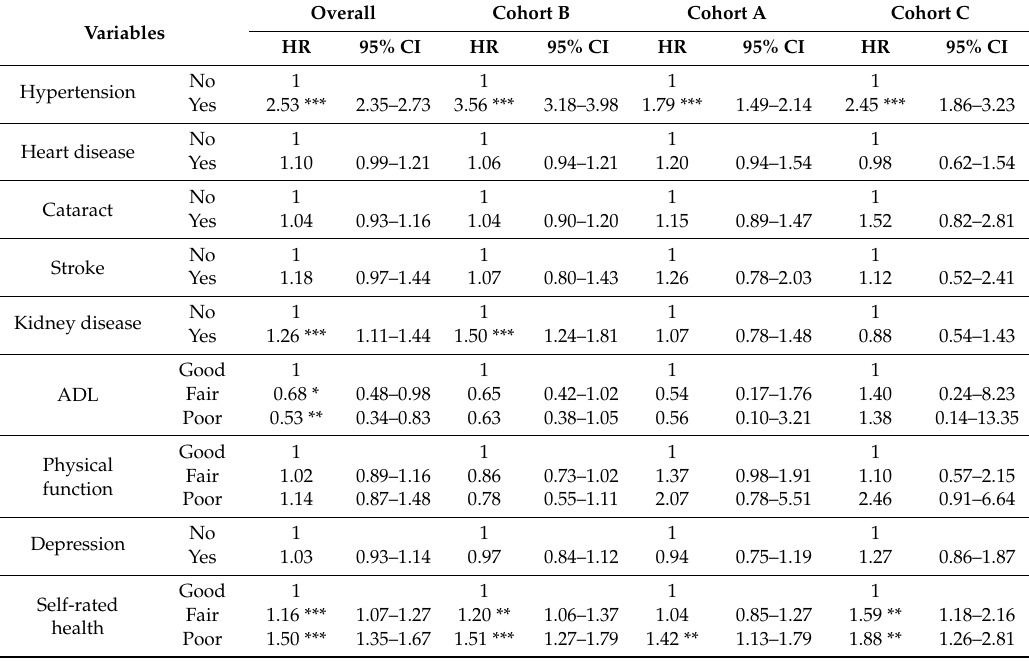
Table 3. Hazard ratio (HR) between variables and diabetes mellitus using the interval-censored Cox